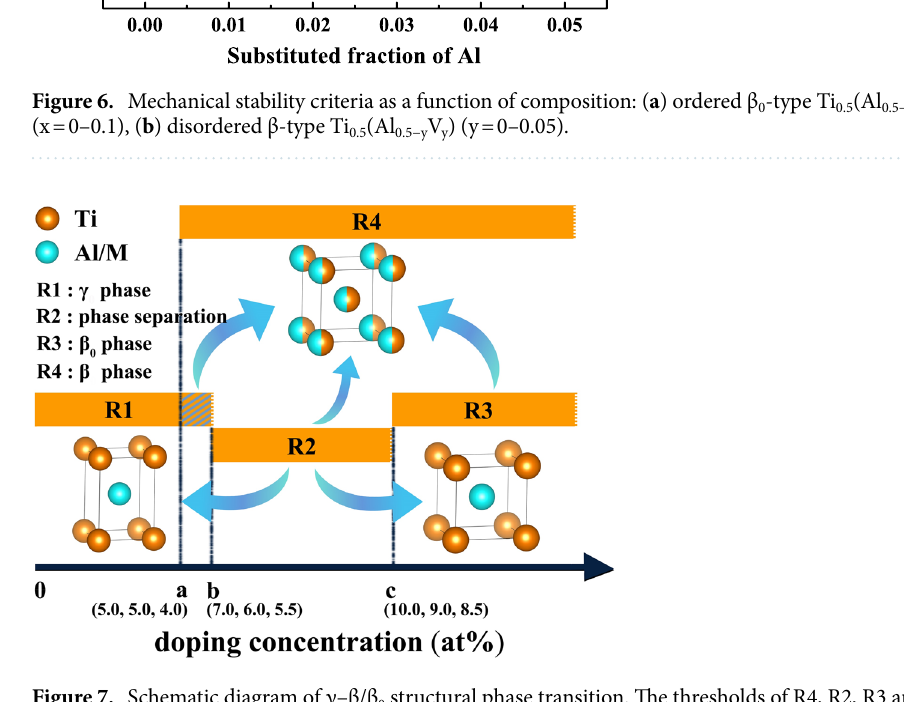
Figure 7. Schematic diagram of γ–β/β 0 structural phase transition. The thresholds of R4, R2, R3 are labeled as ( a , b , c ), respectively. The ternary coordinates of these points correspond to the atomic percentage of V, Cr, Mn,